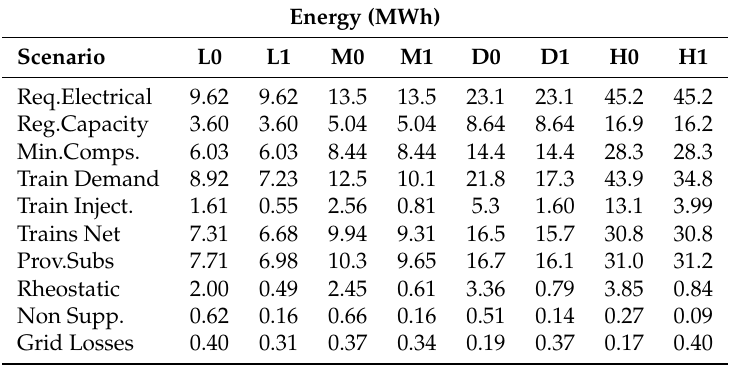
Table 4. Summary of the trains and the network behavior in the different